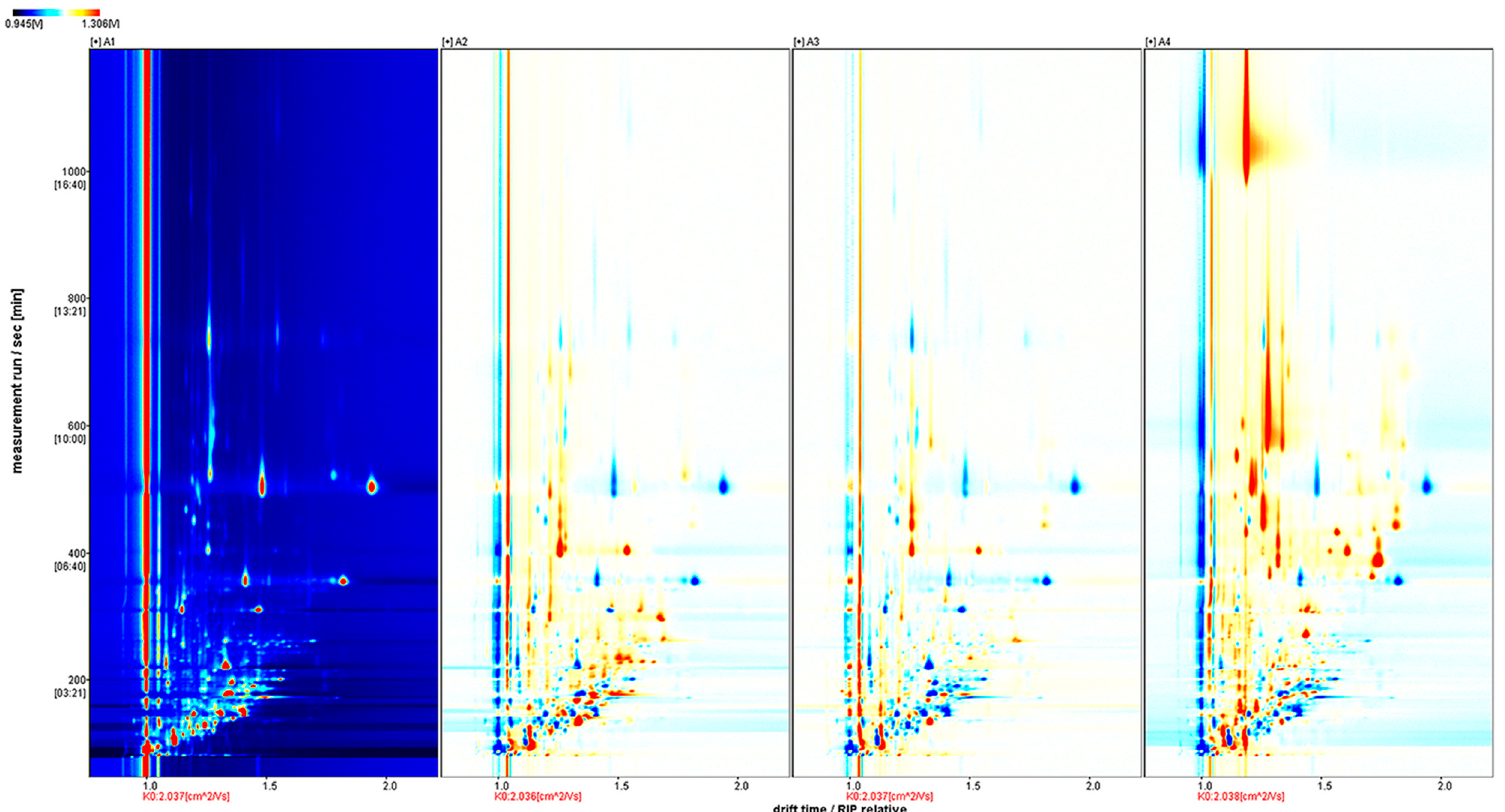
Figure 1. Imaging of volatile compounds represented by HS-GC-IMS of honey samples. A1: Fennel honey; A2: Agastache honey; A3: Pomegranate honey; A4: Manuka 12+ honey.